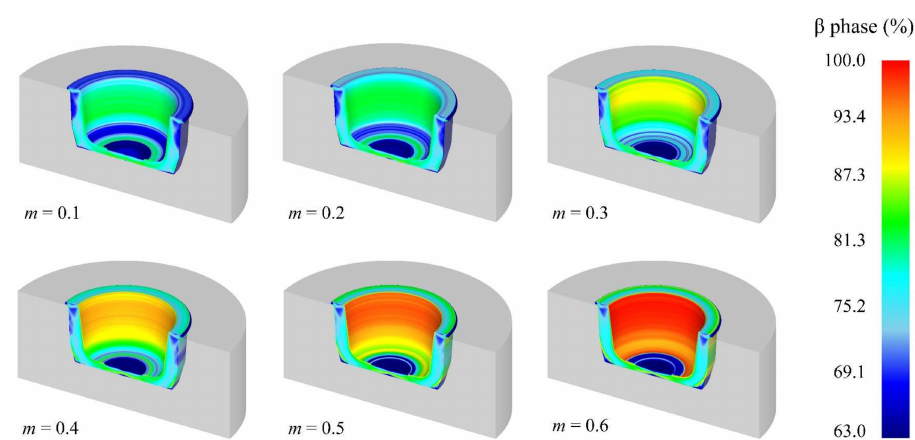
Figure 7. Distributions of β phase under various friction